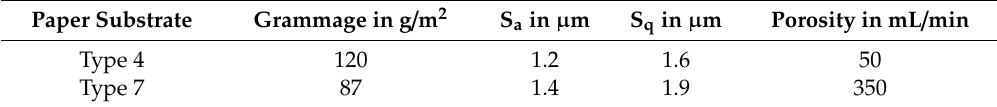
Table 1. Characteristics of the used paper substrates.